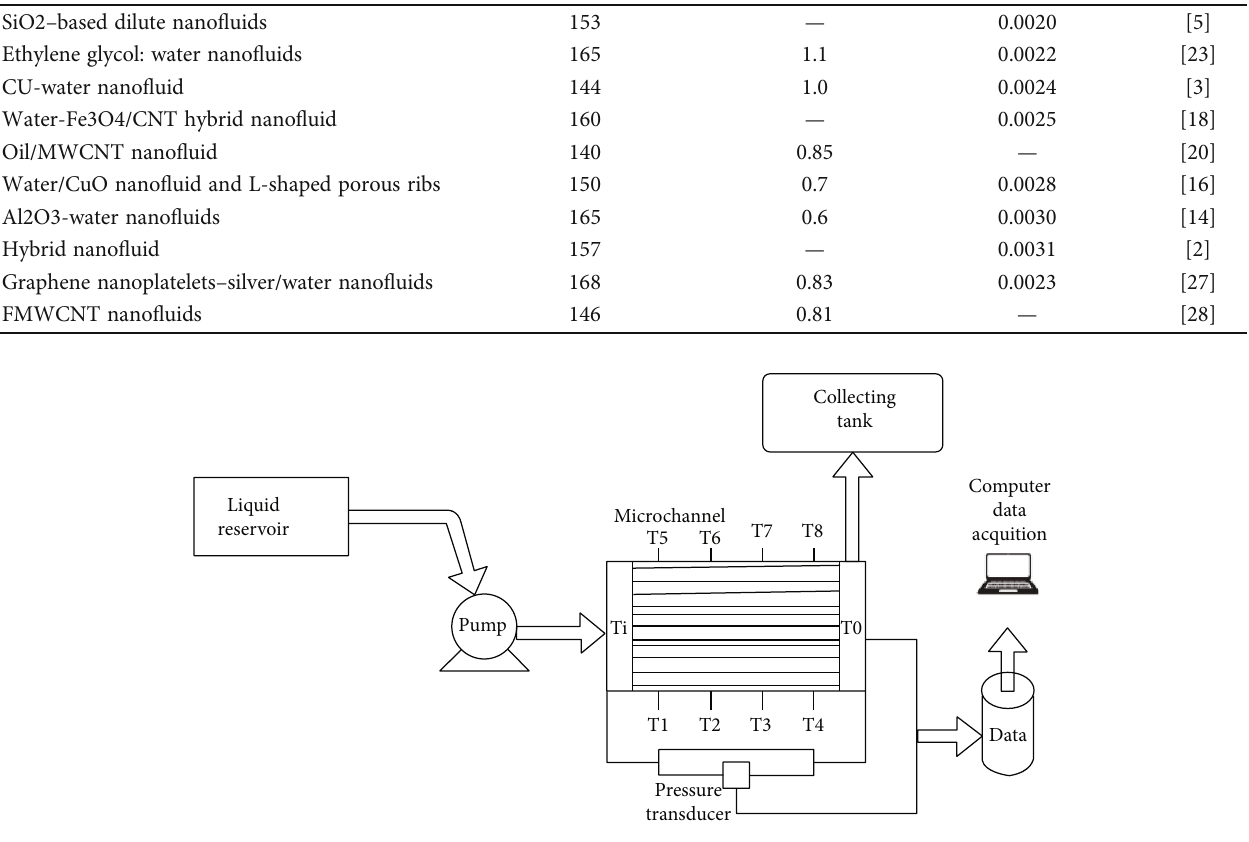
Figure 1: Preparation of nano fl uid using a magnetic stirrer.